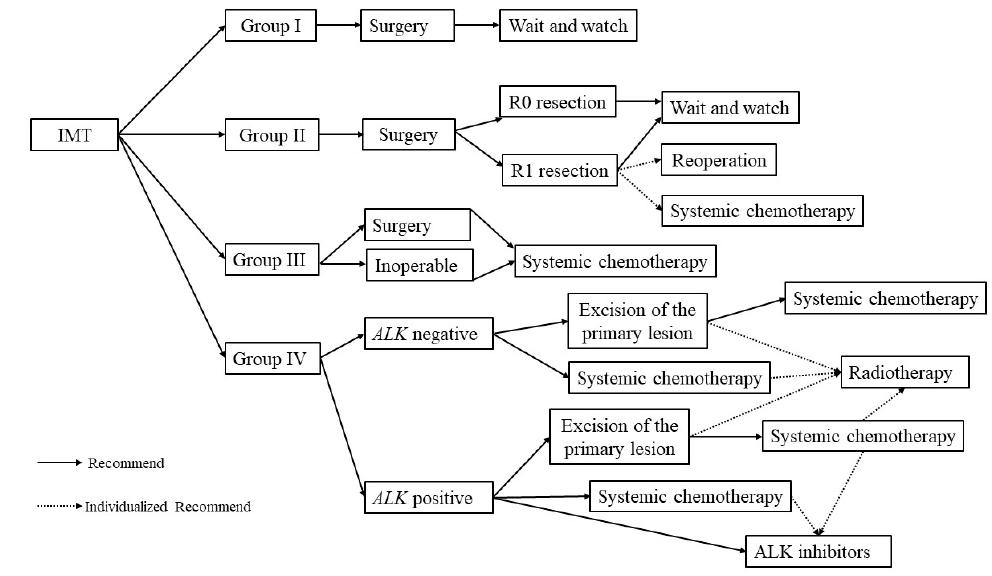
Figure 1. The treatment strategy for IMT.